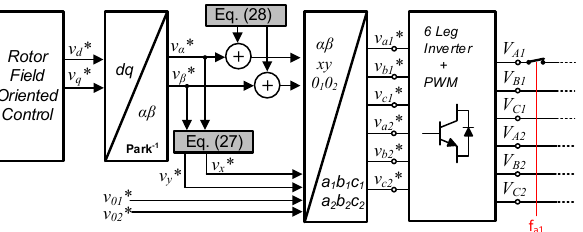
Figure 5. The injection of feedforward term(s) in symmetrical six-phase IM drive. The signal f a1 is to emulate the OPF.